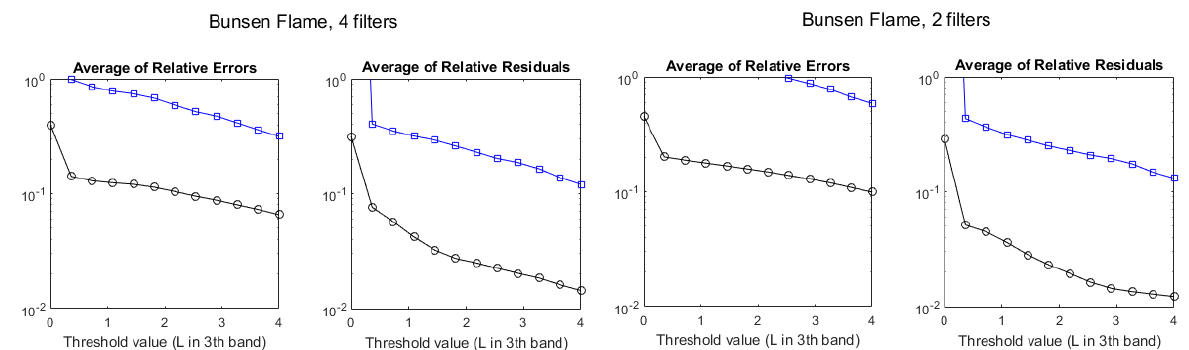
Figure 16. Evolution of the discrepancies between hyperspectral and multispectral temperatures (black circles) and column densities (blue squares), measured as average relative error and average residuals, for the Bunsen flame, as a function of the radiance threshold, measured in W/m 2 · sr · cm − 1 . Left : values retrieved with four filters. Right : values retrieved with two